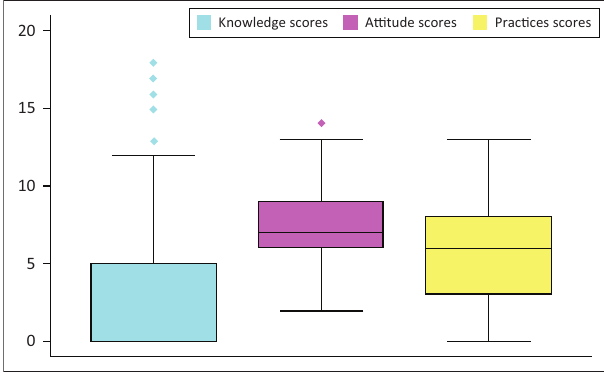
FIGURE 2: Boxplot showing knowledge, attitude and practices score distribution for communal cattle keepers of the Whittlesea community, South Africa, 2017.